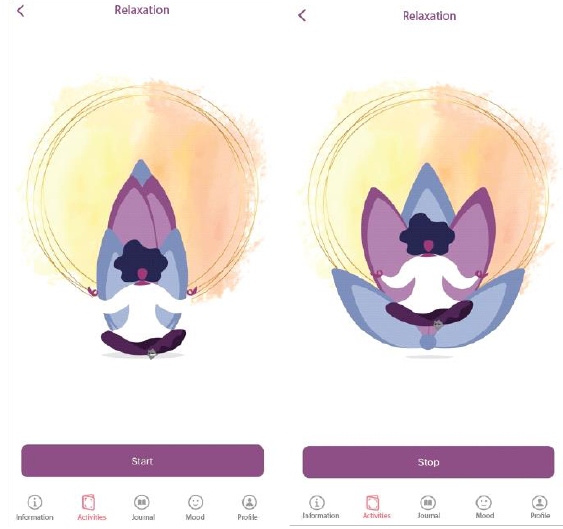
Figure 4. Relaxation in the ADHD Coping Card app.